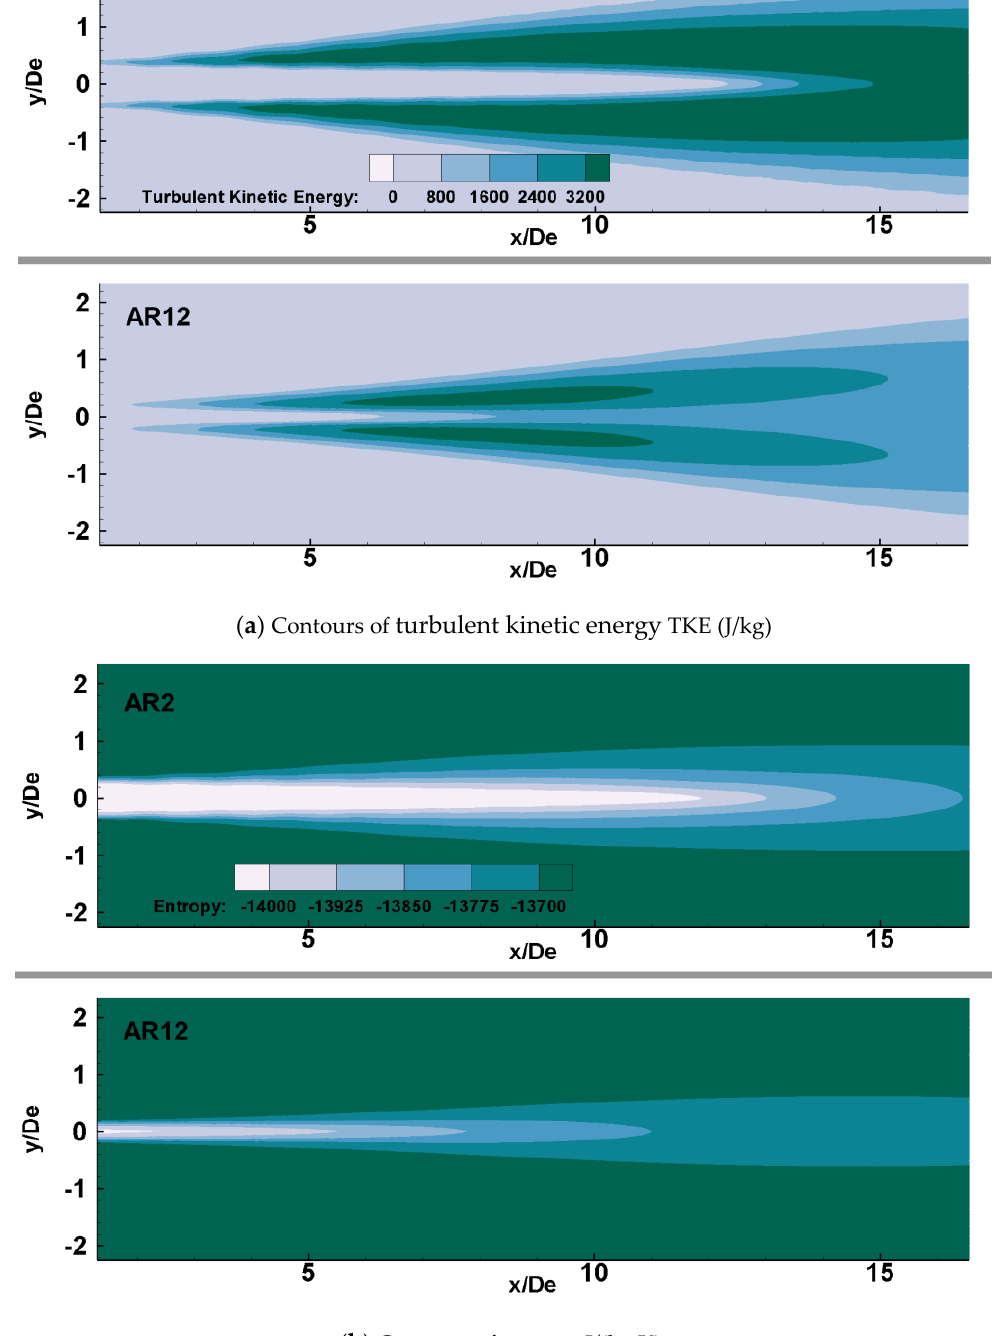
Figure 9. ( a ) Contours of TKE (J/kg), ( b ) contours of entropy J/(kg · K) downstream from the nozzle exit for the AR2 and Figure 9 . ( a ) Contours of TKE (J/kg), ( b ) contours of entropy J/(kg·K) downstream from the nozzle exit for the AR2 and AR12 nozzles on the minor axis symmetry plane. AR12 nozzles on the minor axis symmetry